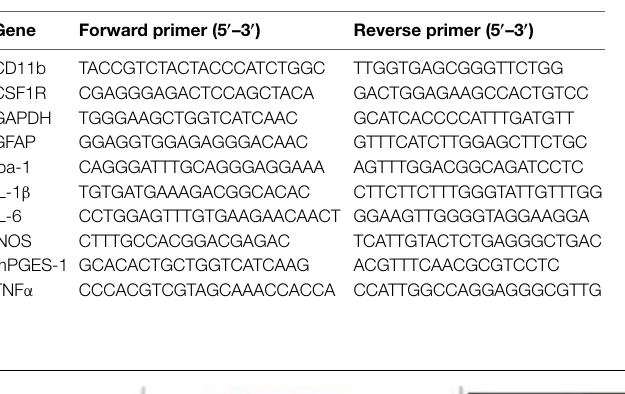
Frontiers in Cellular Neuroscience |